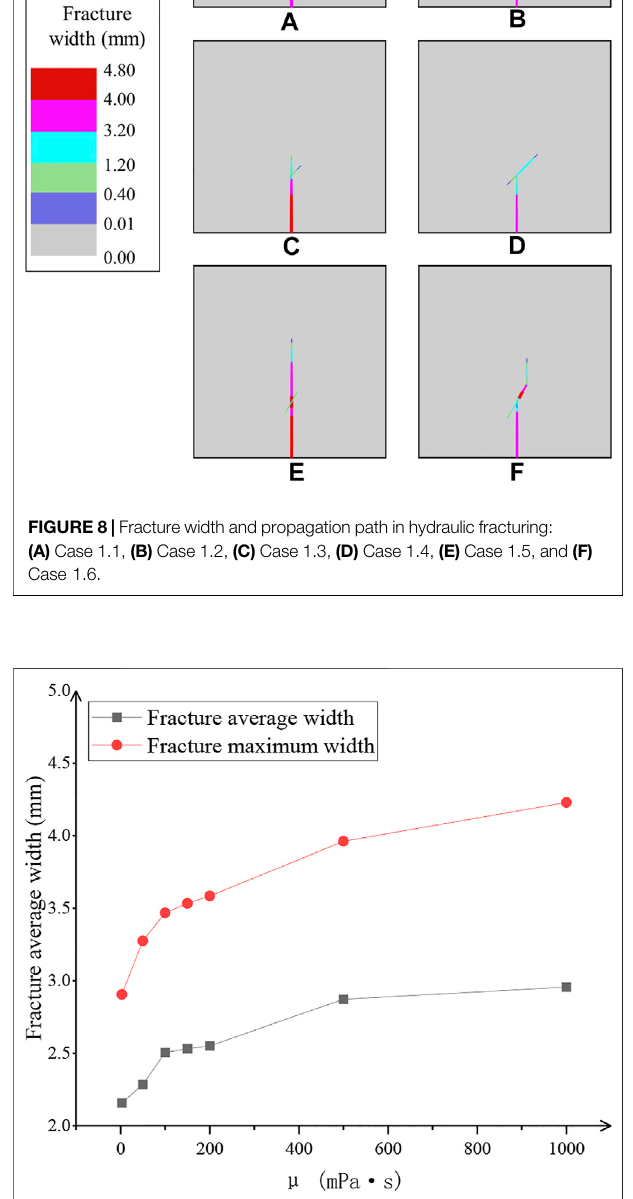
FIGURE 9 | HF width curve with